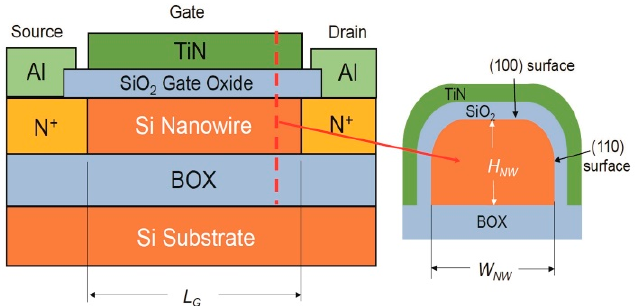
Figure 1. The nanowire transistor structure fabricated for this investigation.